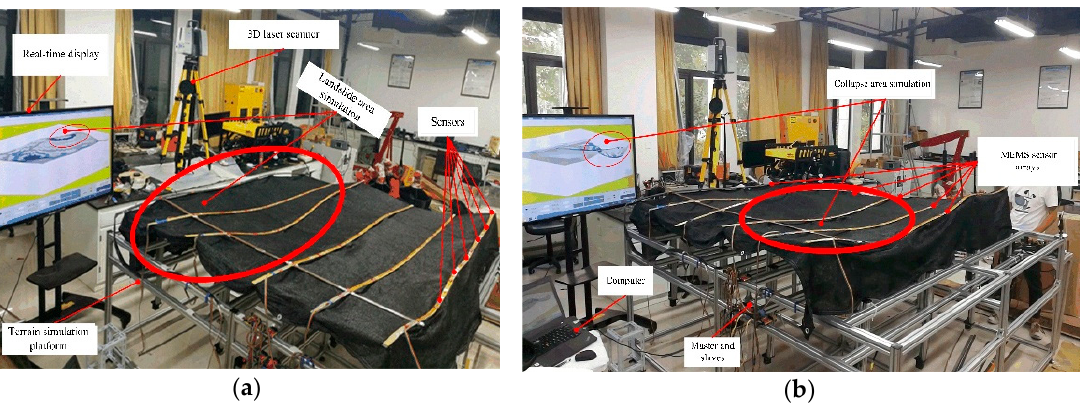
Figure 18. ( a ) Landslide phenomenon simulation test; ( b ) Collapse phenomenon simulation test.